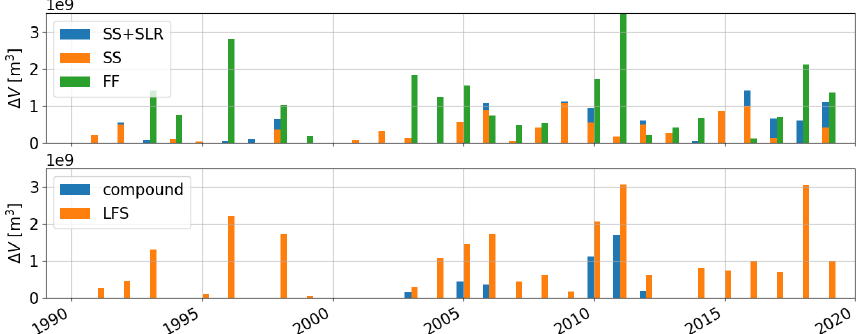
Figure 13. Similar to Fig. 12 but for the interannual variability of (cid:49)V